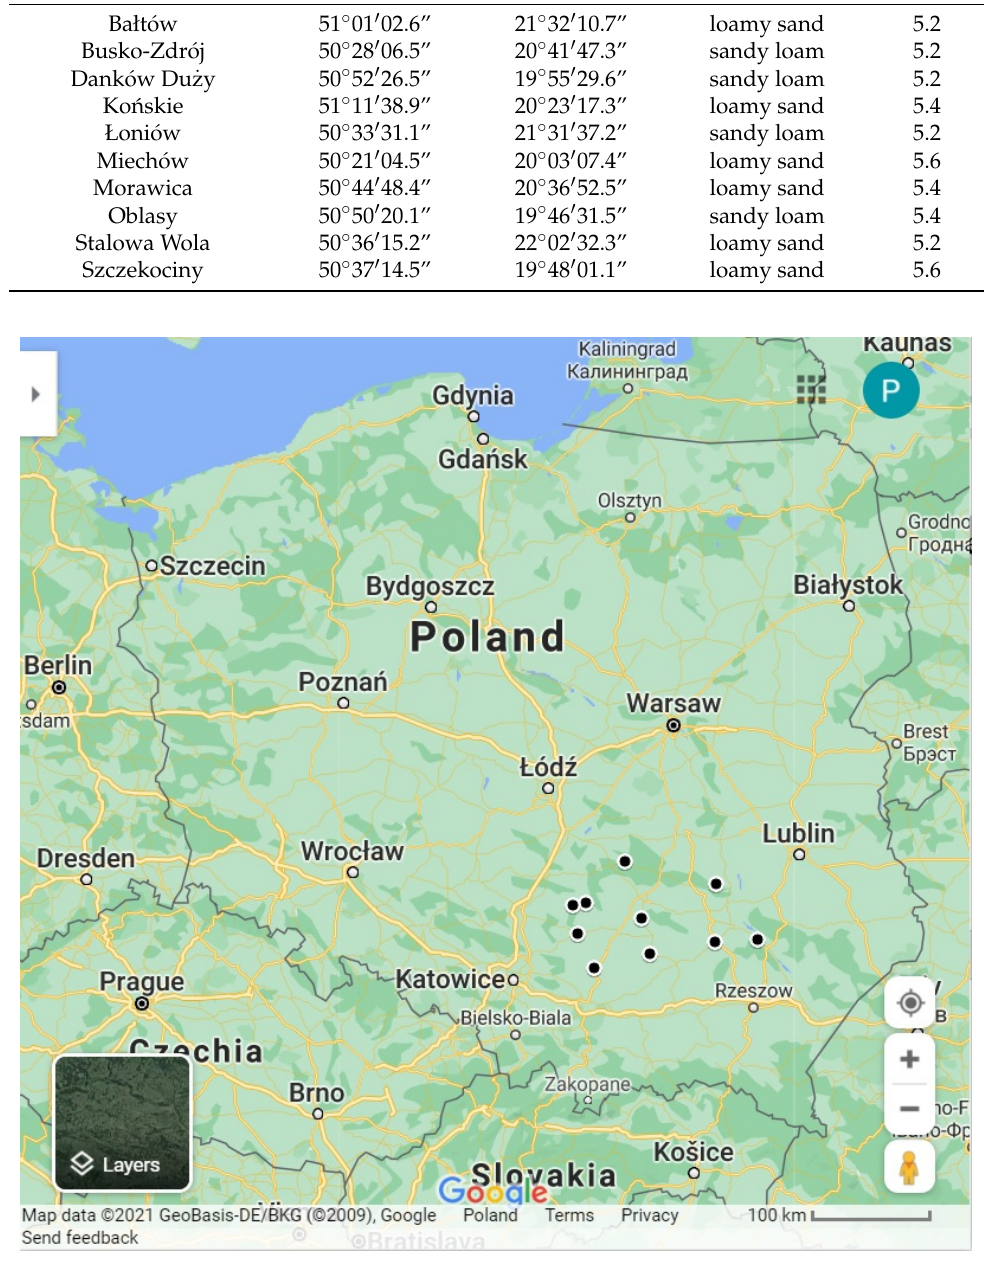
Figure A1. Location of sampling sites—dark circles (https://www.google.com/maps, accessed